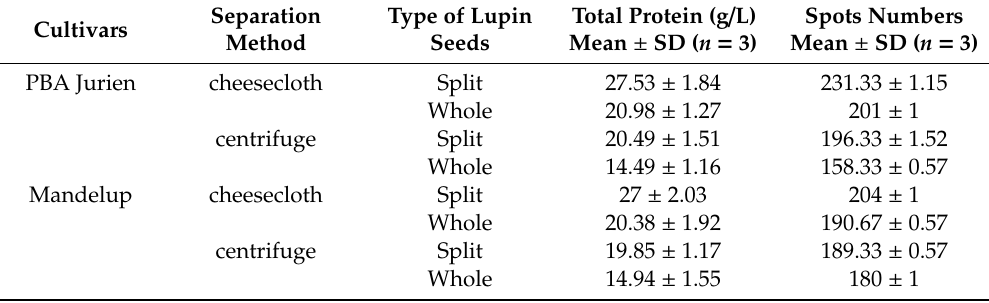
Figure 1. Schematic diagram showing the workflow for extraction of lupin milk and its analysis. Table 1. List of the total protein content and numbers of protein spots detected by PDQuest software from 2DGE gels of lupin milk of each condition.